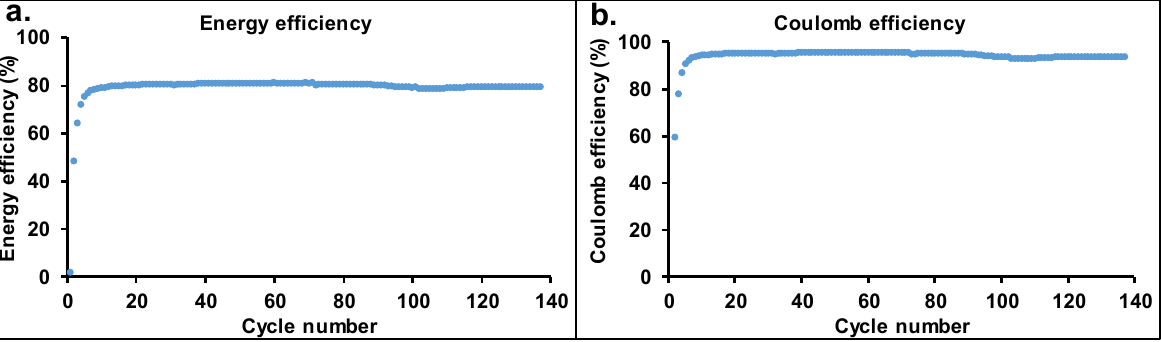
Figure 3. The energy ( a ) and Coulomb efficiency ( b ) of the Zn-air battery equipped with brass anode with additive-free electrolyte, aqueous KOH (6 M) and K 2 [(Zn(OH) 4 )] (0.25 M).